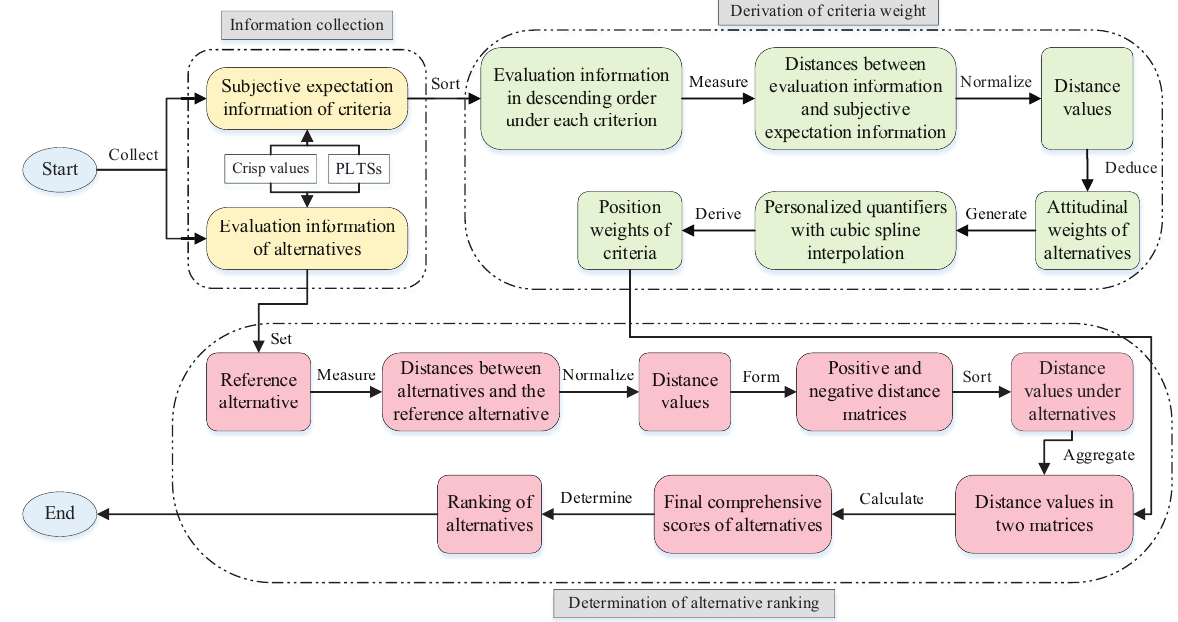
Figure 1. The flow chart of the personalized quantifier-based MACONT